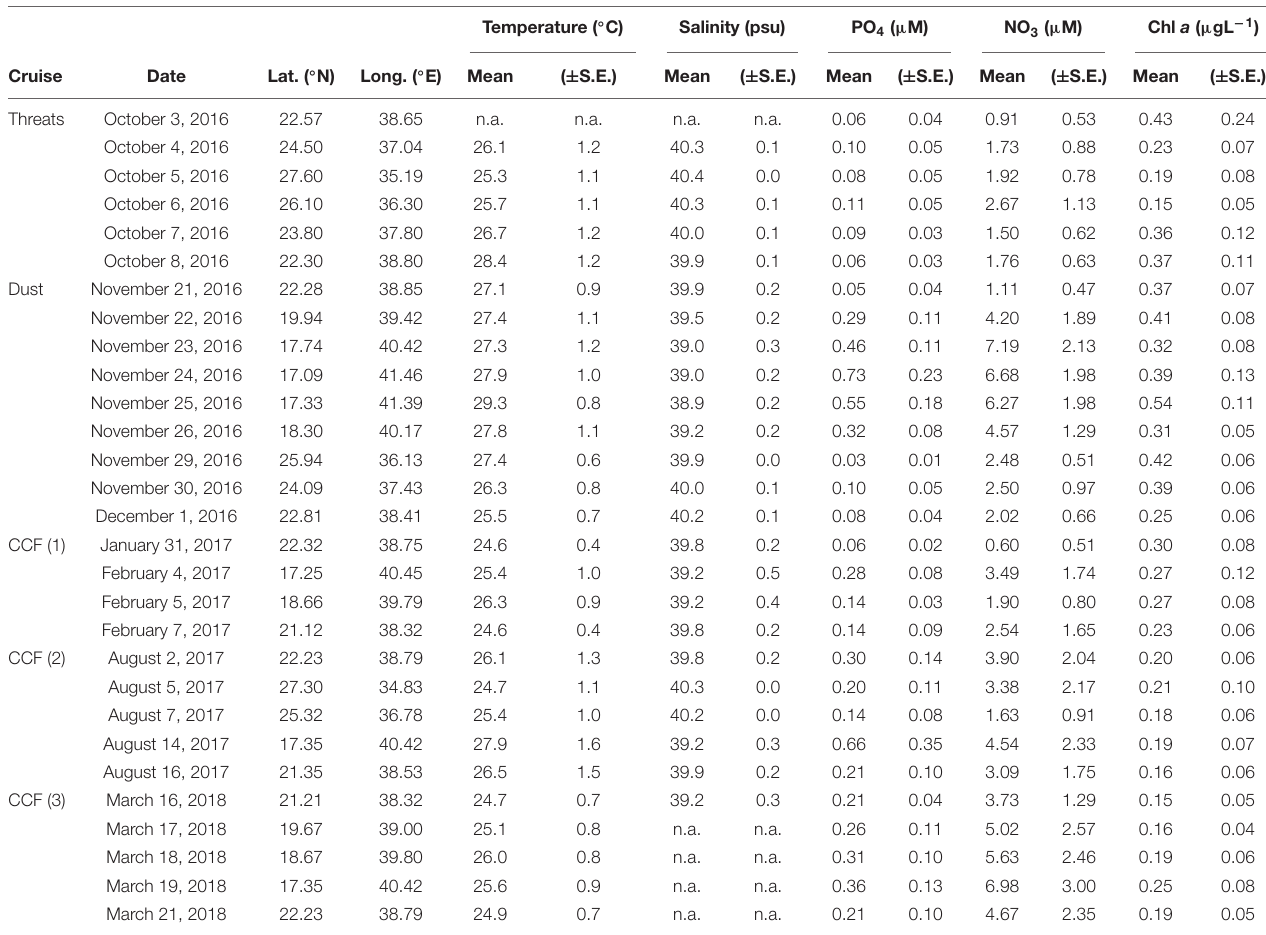
TABLE 1 | Cruise name, sampling dates, and coordinates of the sites analyzed during this study, together with the water-column average values ( ± standard errors) for temperature, salinity, nutrients, and chlorophyll a concentration measured at each